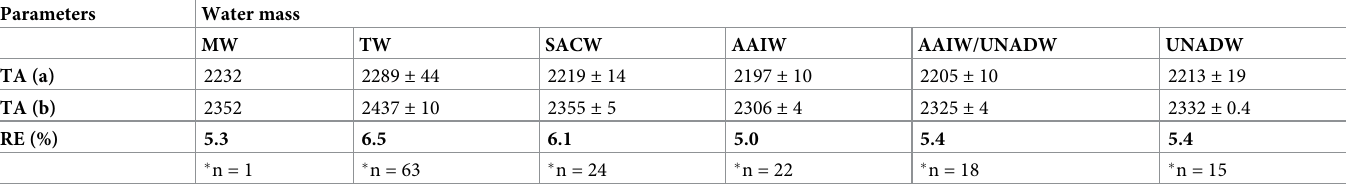
Table 8. Variations in TA ( μ mol/kg) were obtained analytically and calculated with the AQM program [1, 13–15]. In calculating the relative error (RE%), the values obtained analytically are the expected values (see item Analytical Procedure: TA and Table 3).